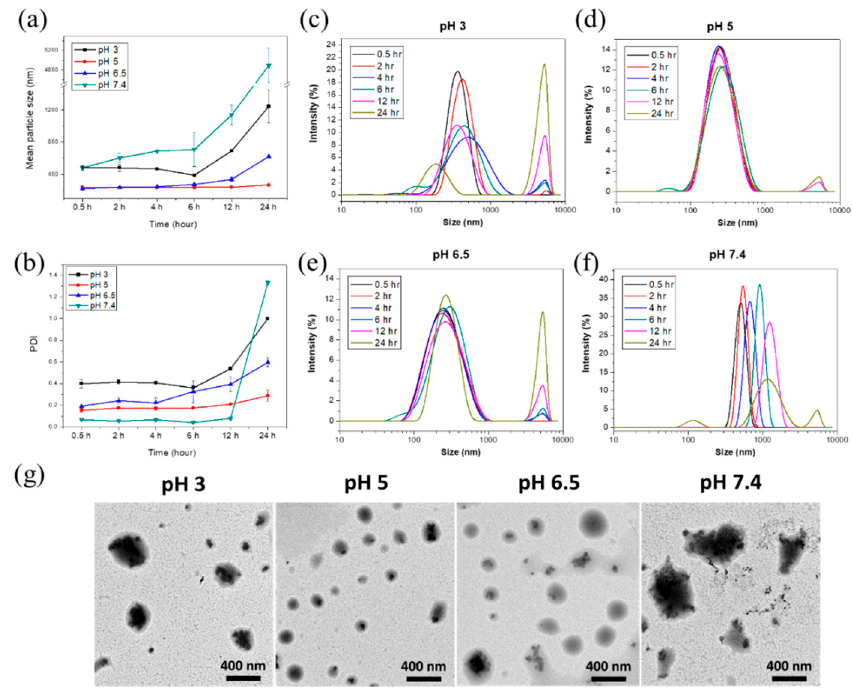
Figure 3. ( a ) Mean particle size, ( b ) PDI, ( c – f ) size distribution curves, and ( g ) TEM micrographs of CS/OJPs/CL NPs after 6 h at different pH conditions. CS/OJPs/CL NPs after 6 h at different pH